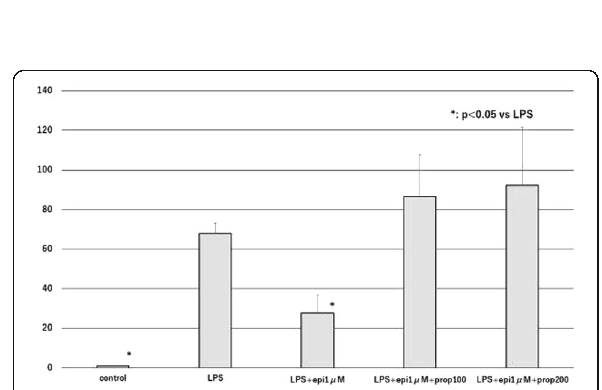
Fig. 3 (abstract 0130) . The effects of propranolol on TNF- α expression after LPS and epinephrine(1 μ M)